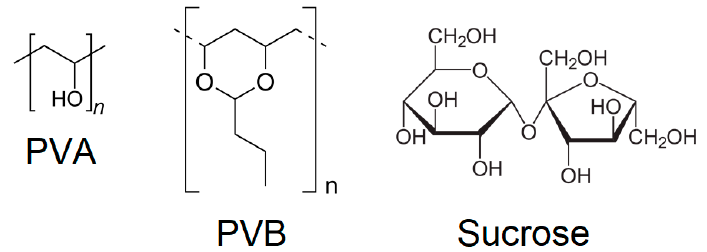
Figure 3. Molecular formulas of the binders employed in this study. From left to right: polyvinylalcohol (PVA), polyvinylbutyral (PVB) and sucrose.